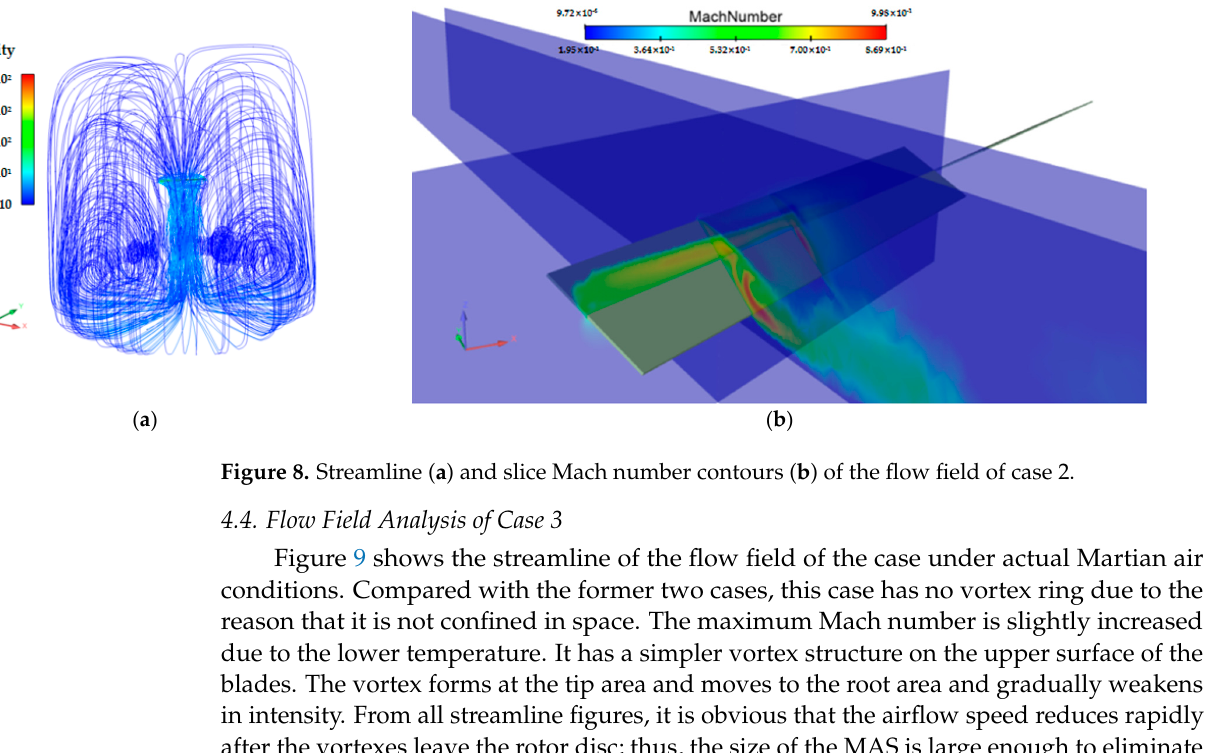
Figure 8. Streamline ( a ) and slice Mach number contours ( b ) of the flow field of case 2.